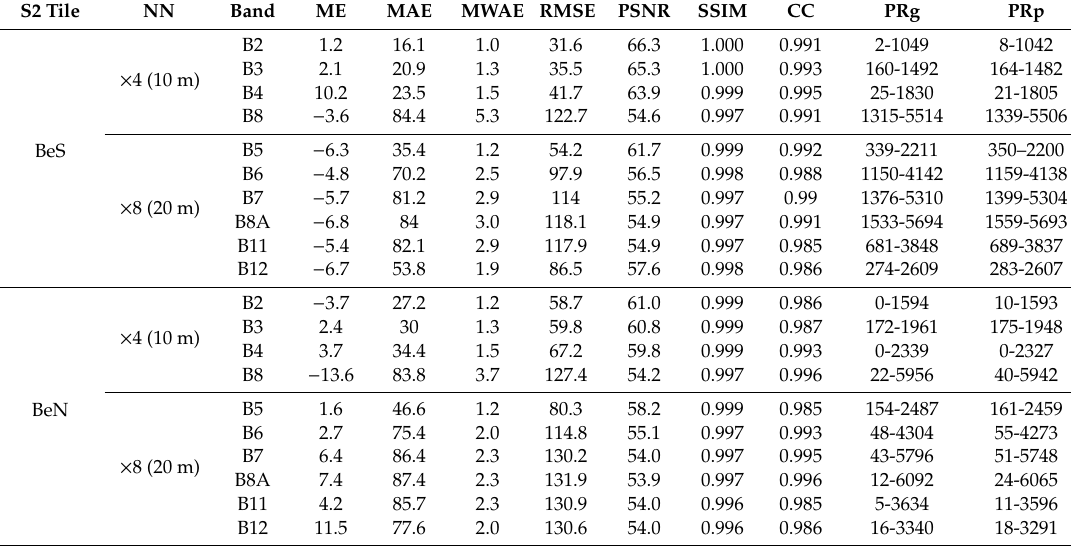
Table 5. Measured quality of the two super-resolution neural networks (NNs), from 10 to 2.5 m ( × 4) and from 20 to 2.5 m ( × 8), by band (10 bands) for the two Belgian S2 tiles (BeS and BeN) (Figure 3). ME, mean error; MAE, mean absolute error; MWAE (%), mean weighted absolute error. RMSE, root mean square error; PSNR, peak signal noise ratio; SSIM, structure similarity; CC, cross correlation; PRg, 1st-99th percentiles of ground truth data; PRp, 1st-99th percentiles of predicted